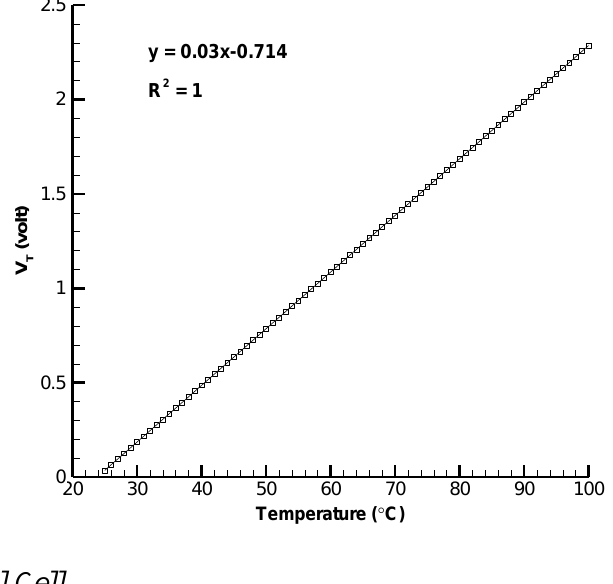
Figure 8. Calibration of wireless integration for temperature